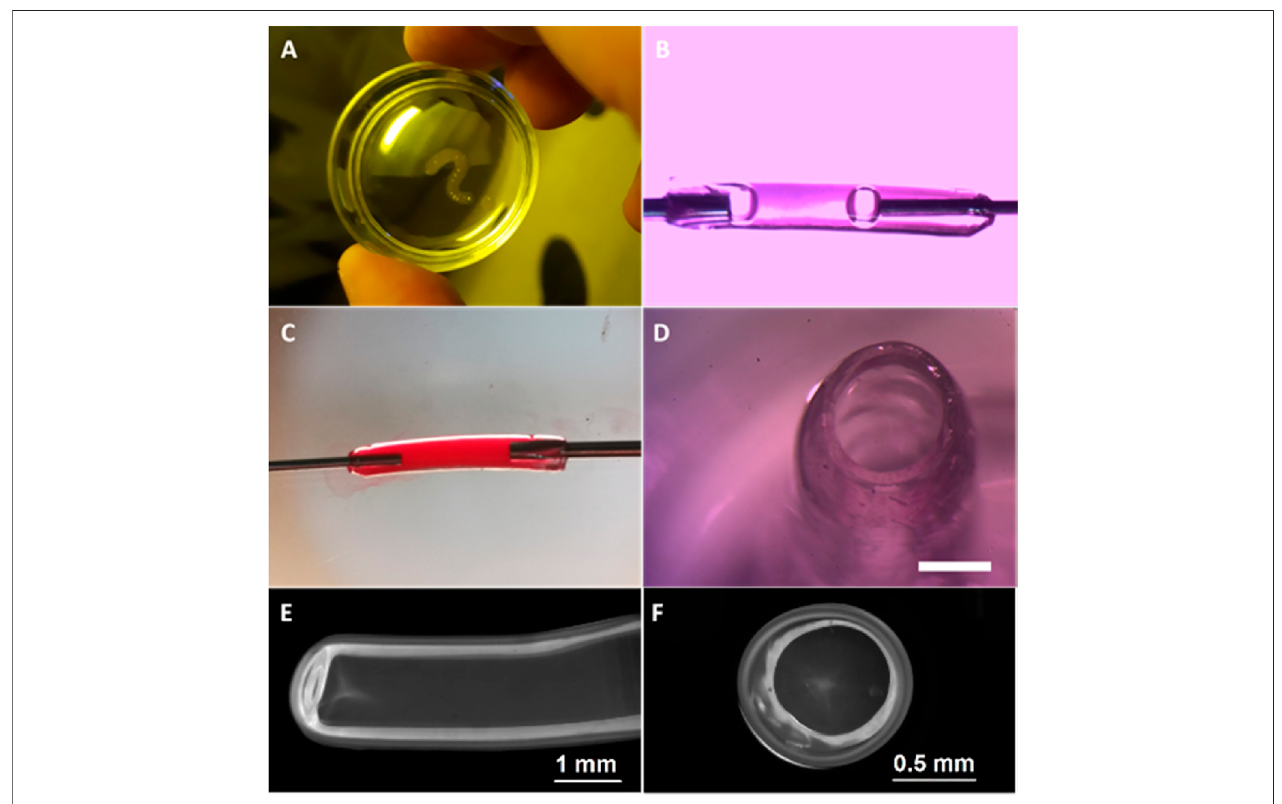
FIGURE 4 | Image of fabricated hydrogel structures. (A) Structure printed with the shape of “ question mark sign ” . (B) Bubbled fl uid fl ow through the fi ber and (C) colorized liquid fl ux fl owing through the hollow-core fi ber. (D) Cross-sectional view of the fi ber after developing, scale bar 1 mm. (E) Fiber produced by 600 µm nozzle and (F) its cross-sectional